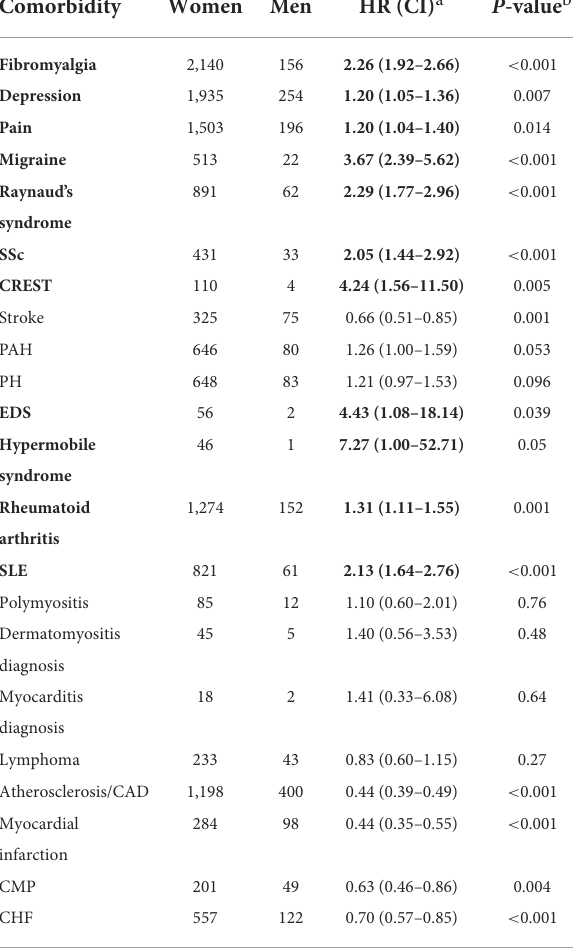
TABLE 11 Relative risk of developing a comorbidity in women vs. men with Sjögren’s disease ( n = 13,849). Comorbidity